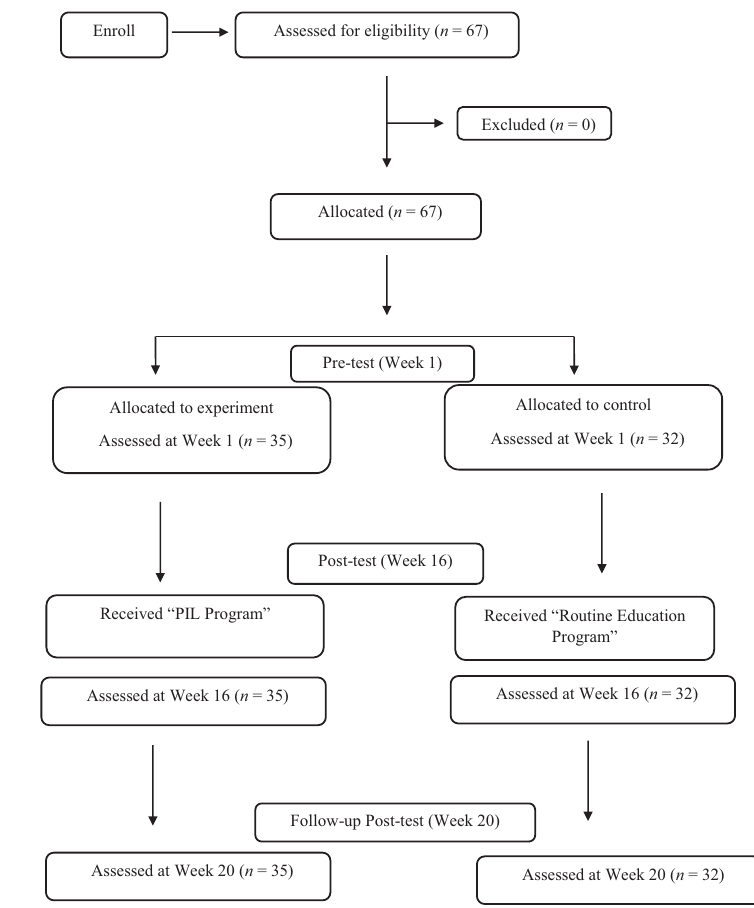
Figure 1. Flow-chart of the